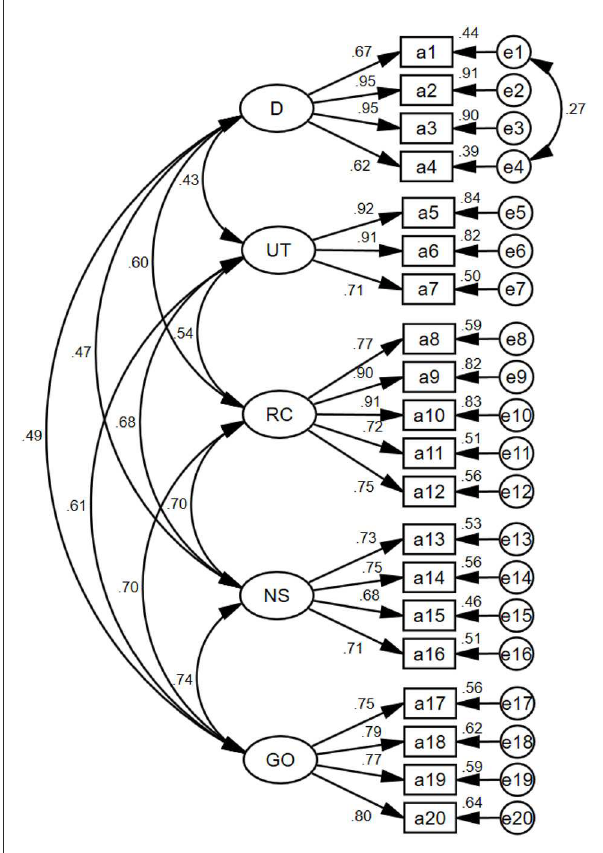
TABLE 4 Factor loadings of EFA for Chinese DoCCA scale.